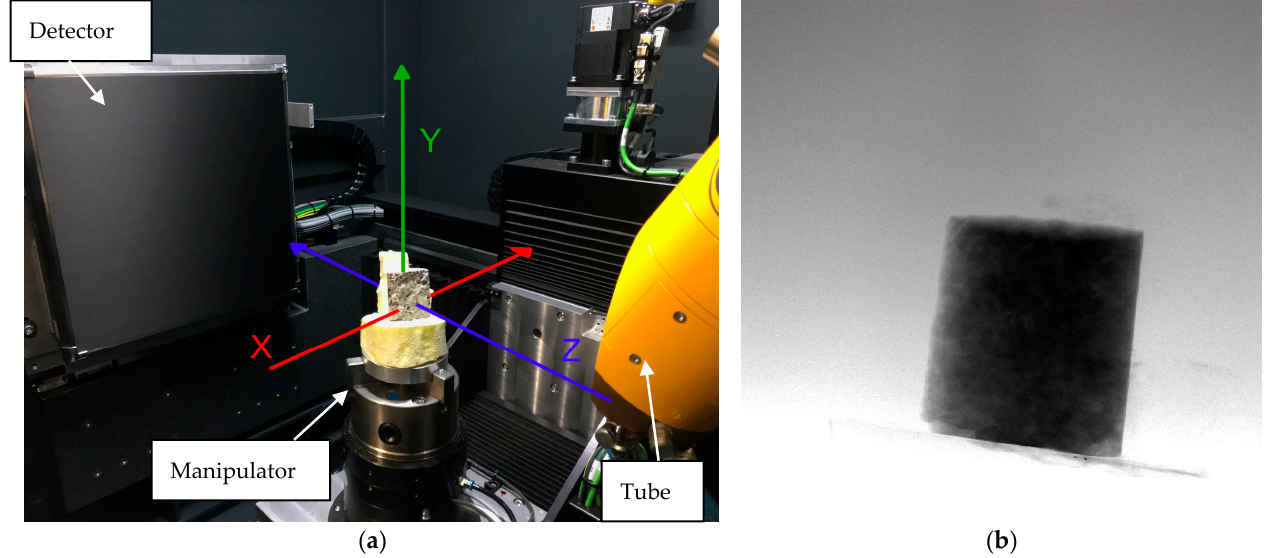
Figure 4. CT scans ( a ) interior of the CT chamber; ( b ) single projection. Source: own materials.